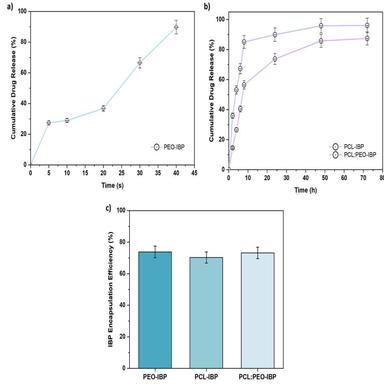
a) IBP released from PEO fibers, b) IBP released from PCL and optimized binary PCL:PEO fibers and c) encapsulation efficiency of IBP in all three composites.